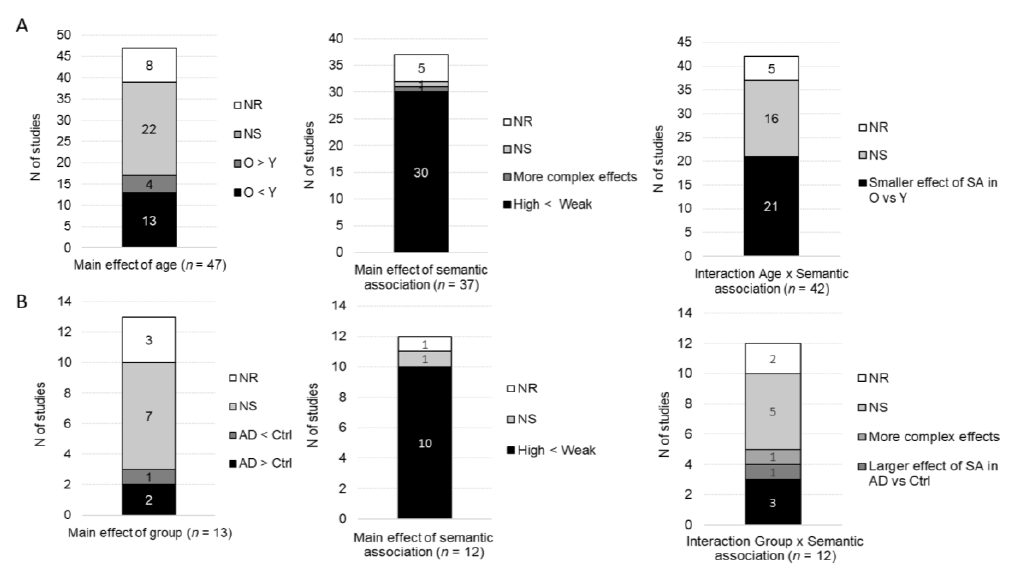
Figure 5. Qualitative results for the N400 amplitude: main effects of age/group, semantic association and the interaction group x semantic association. ( A ) Studies including older and younger groups of participants. ( B ) Studies including AD participants and control groups. N of studies: Number of studies; O: Older; Y: Younger; AD: Alzheimer’s disease; Ctrl: Control group(s); NS: No significant effect; NR: Statistical significance not reported; SA: Semantic association. Brain Sci. 2020 , 10 , x FOR PEER REVIEW